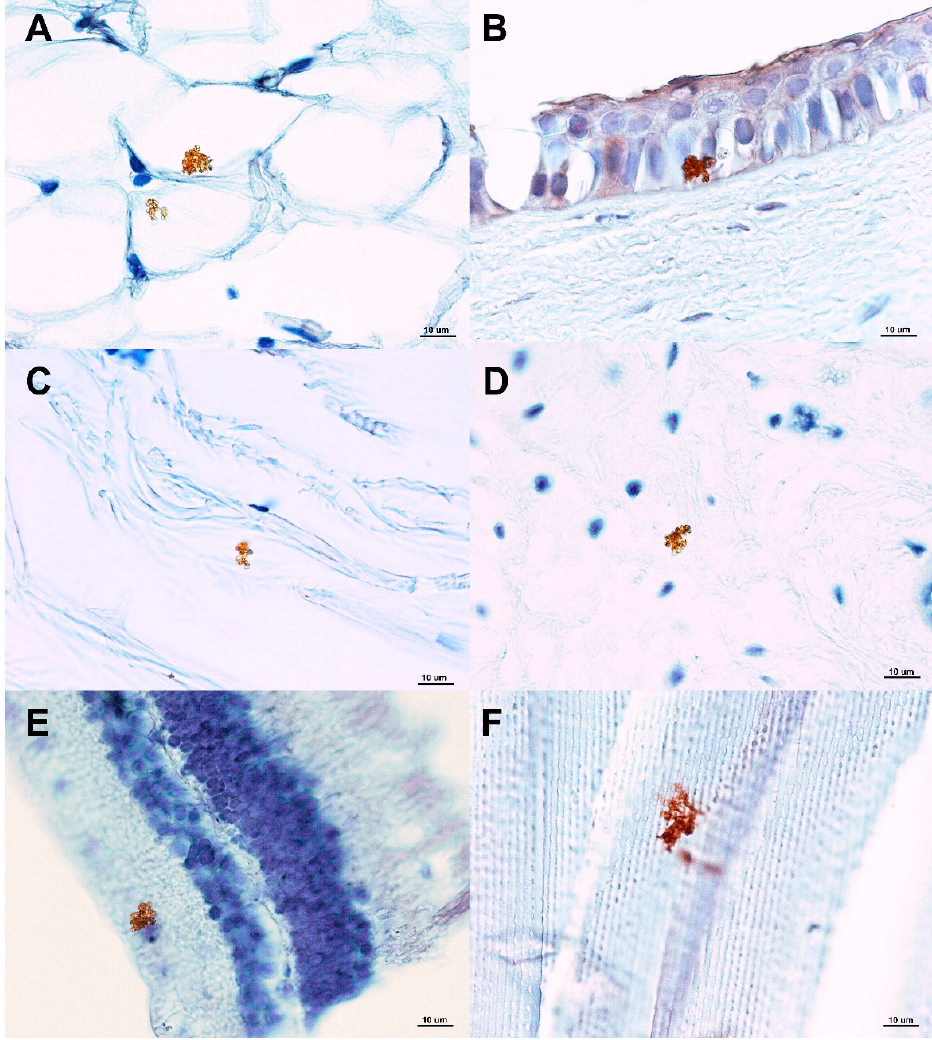
Figure 1. Identification of Encephalitozoon cuniculi using immunohistochemistry (with specific monoclonal anti- E. cuniculi antibody EC11C5) in various ocular structures in experimentally orally infected rabbits. Legend: ( A ) Periocular connective tissue (fat); ( B ) cornea ( E. cuniculi detected in corneal epithelial cells); ( C ) sclera; ( D ) iris; ( E ) retina ( E. cuniculi detected in the retinal ganglion layer); ( F ) lens (lens fibres). Table 1. Detection rates of E. cuniculi in the examined ocular structures of rabbits at different time